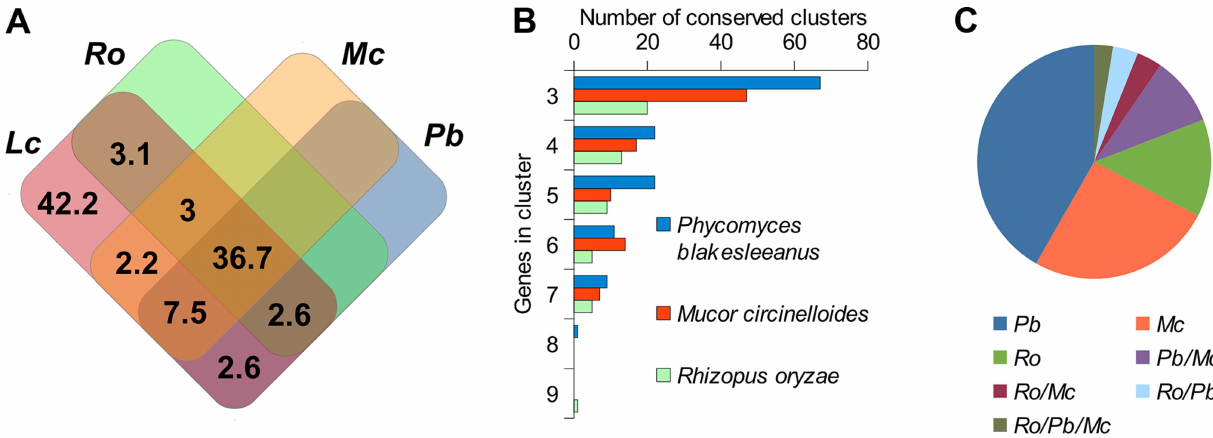
Figure 2. Conserved regions of the L.corymbifera genome with other mucoralean genomes. (A) Venn diagram of shared gene families between L. corymbifera and other mucoralean fungi based on GhostFam gene families. Numbers indicate percentage of L. corymbifera gene families. (B) Number and size of conserved clusters of L. corymbifera with other mucoralean genomes. (C) Proportions of conserved clusters of L. corymbifera shared with different mucoralean genomes. Occurrences in more than one of the genomes are indicated by a slash between the species.